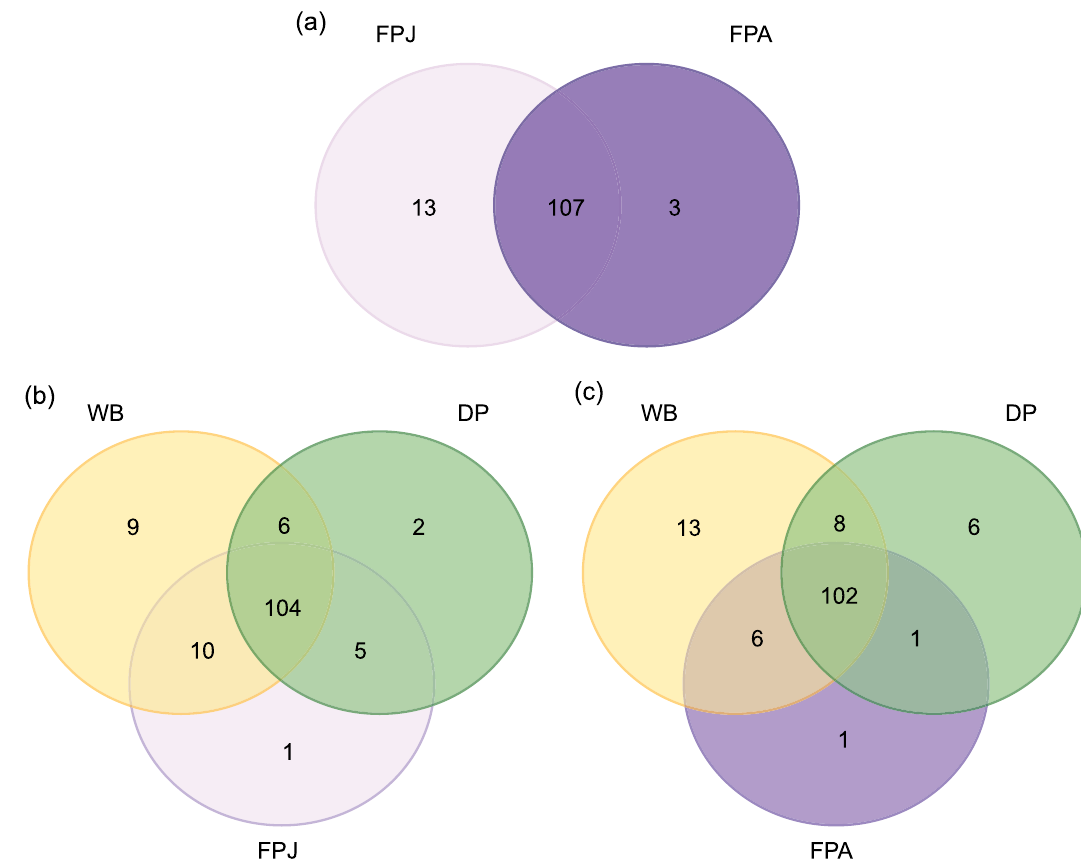
Fig. 3 Symmetric Venn diagrams of genera (based on the presence / absence) of the gut microbiota. Comparison between juvenile (FPJ) and adult (FPA) feral pigs (a). Comparison among wild boar (WB), domestic pig (DP) and juvenile feral pig (FPJ) (b); comparison among wild boar, domestic pig and and adult feral pig (FPA)